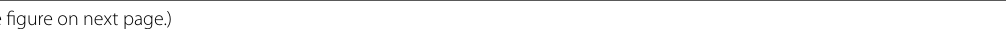
Fig. 7 a Transient signals recorded at 2 s sampling rate during April 29, 2010. Upper plots are from the DAK site. Left: Horizontal components of tilt, NS (black) and EW (blue). Middle: Electric field components, SN (black) and EW (blue). Right: Ground temperature at 40 cm depth (black) and seismic RMS noise (blue). Lower plots are from the MCL site. Left: Horizontal north and east components of the magnetic field, H (blue) and D (black), respectively. Middle: Electric field components, NS (black) and EW (blue). Right: Ground temperature at 40 cm depth (black) and seismic RMS noise (blue). b Transient signals recorded at 2 s sampling rate during June 10, 2010. Upper plots are from the DAK site. Left: Horizontal components of tilt: NS (black) and EW (blue). Middle: Electric field components, SN (black) and EW (blue). Right: Ground temperature at 40 cm depth (black) and seismic RMS noise (blue). Lower plots are from the MCL site. Left: Horizontal north and east components of the magnetic field, H (blue) and D (black), respectively. Middle: Electric field components, NS (black) and EW (blue). Right: Ground temperature at 40 cm depth (black) and seismic RMS noise (blue). c Transient signals recorded at 2 s sampling rate (DAK and MCL) between July 11 and 14, 2010. Upper plots are from the DAK site. Left: Horizontal components of tilt, NS (black) and EW (blue). Middle: SN (black) and EW (blue) electric field components. Right: Ground temperature at 40 cm depth (black) and seismic RMS noise (blue). Lower plots are from the MCL site. Left: Water temperature in Main Crater Lake (15 min. sampling). Middle: Electric field components at MCL, NS (black) and EW (blue). Right: Ground temperature at 40 cm depth (black) at MCL